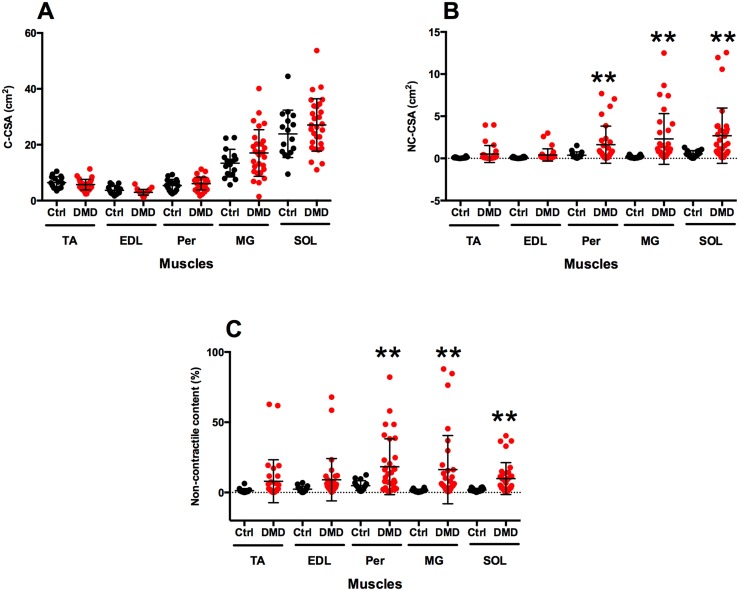
Contractile cross sectional area (C-CSA), non-contractile cross sectional area (NC-CSA), and non-contractile content (NCC) of all the lower leg muscles of boys with DMD and healthy control subjects.Significant difference was found in NC-CSA and of peroneal (Per), medial gastrocnemius (MG), and soleus (SOL) (denoted by **, p<0.05). No differences were observed in C-CSA of DMD and Ctrl leg muscles when all age groups were combined. Data is presented as mean (SD).